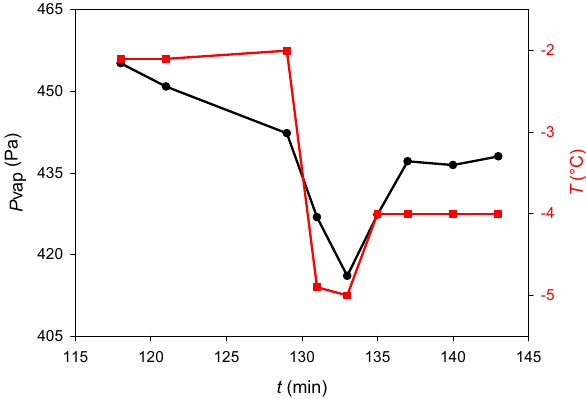
Figure 4. Typical behavior of the humidity during ice deposition on mica in the mEC: (black circle) water vapor pressure in the chamber and (red square) substrate